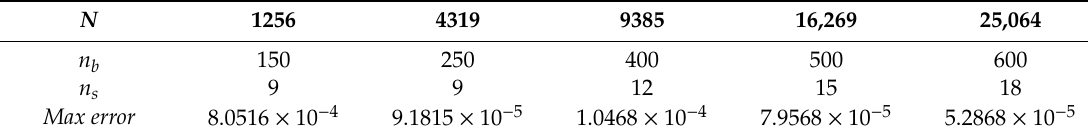
Table 3. Maximum absolute error for case 3.